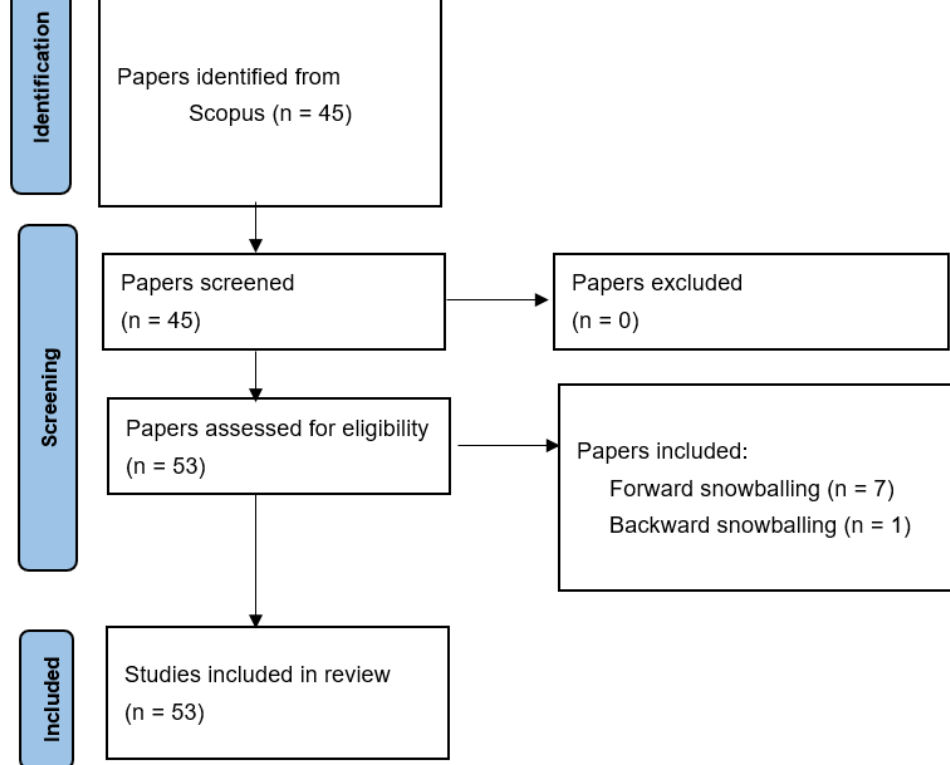
Figure 1. PRISMA flowchart of the review selection process.